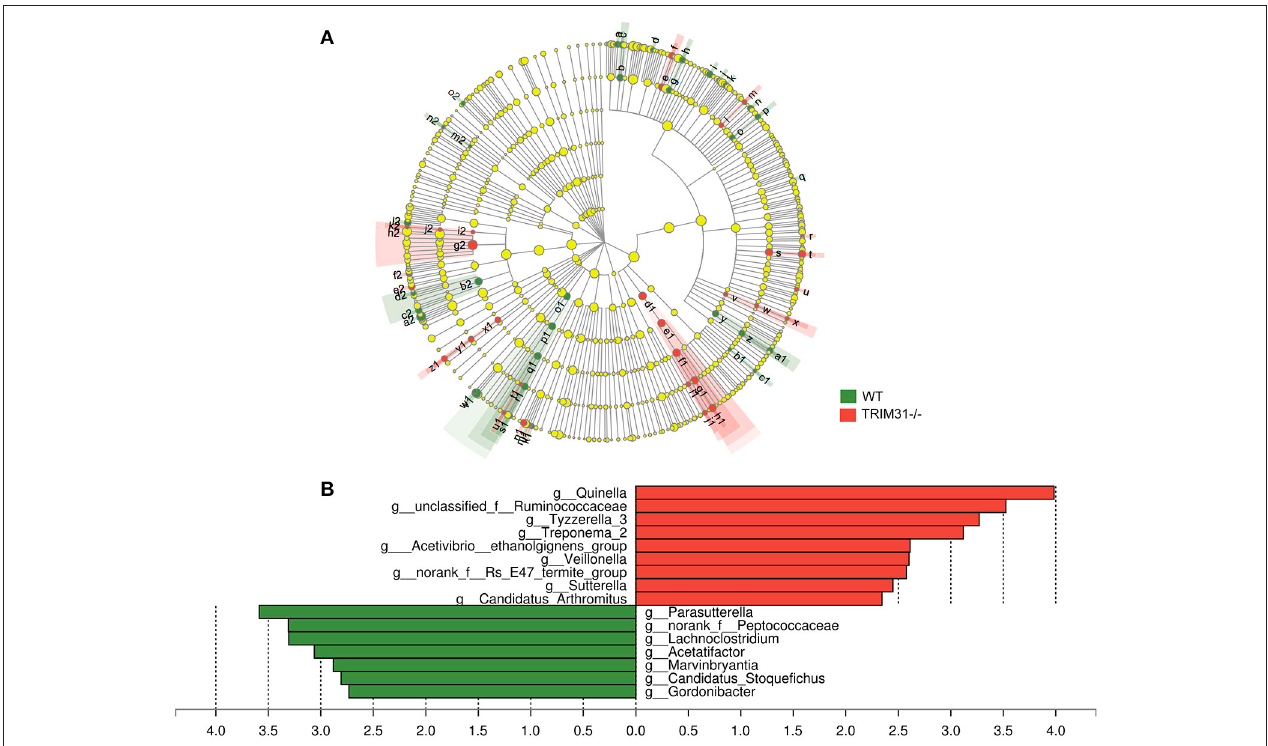
FIGURE 3 | Different profiles of gut microbiota between TRIM31 − / − and WT mice. (A) Cladogram representation of gut microbiota taxa, from the phylum level to the bacteria level. Red indicates taxa enriched in TRIM31 − / − mice, and green indicates taxa enriched in WT mice. The diameter of each circle is proportional to the taxon’s abundance. (B) Histogram of the LDA scores for differentially abundant taxa (red: TRIM31 − / − mice; green: WT mice). LDA scores were calculated by LDA effect size, by using linear discriminant analysis. n = 7, in each group. LDA, linear discriminant analysis; WT, wide-type.